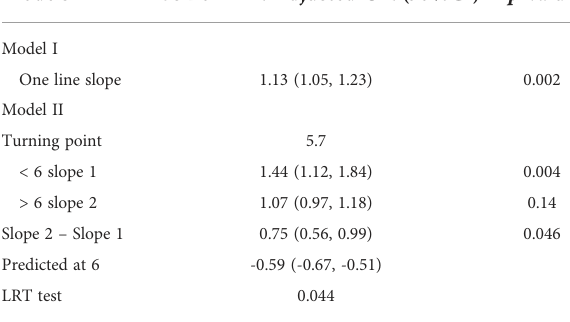
TABLE 2 Threshold effect analysis for the relationship between HbA1c and HPV.